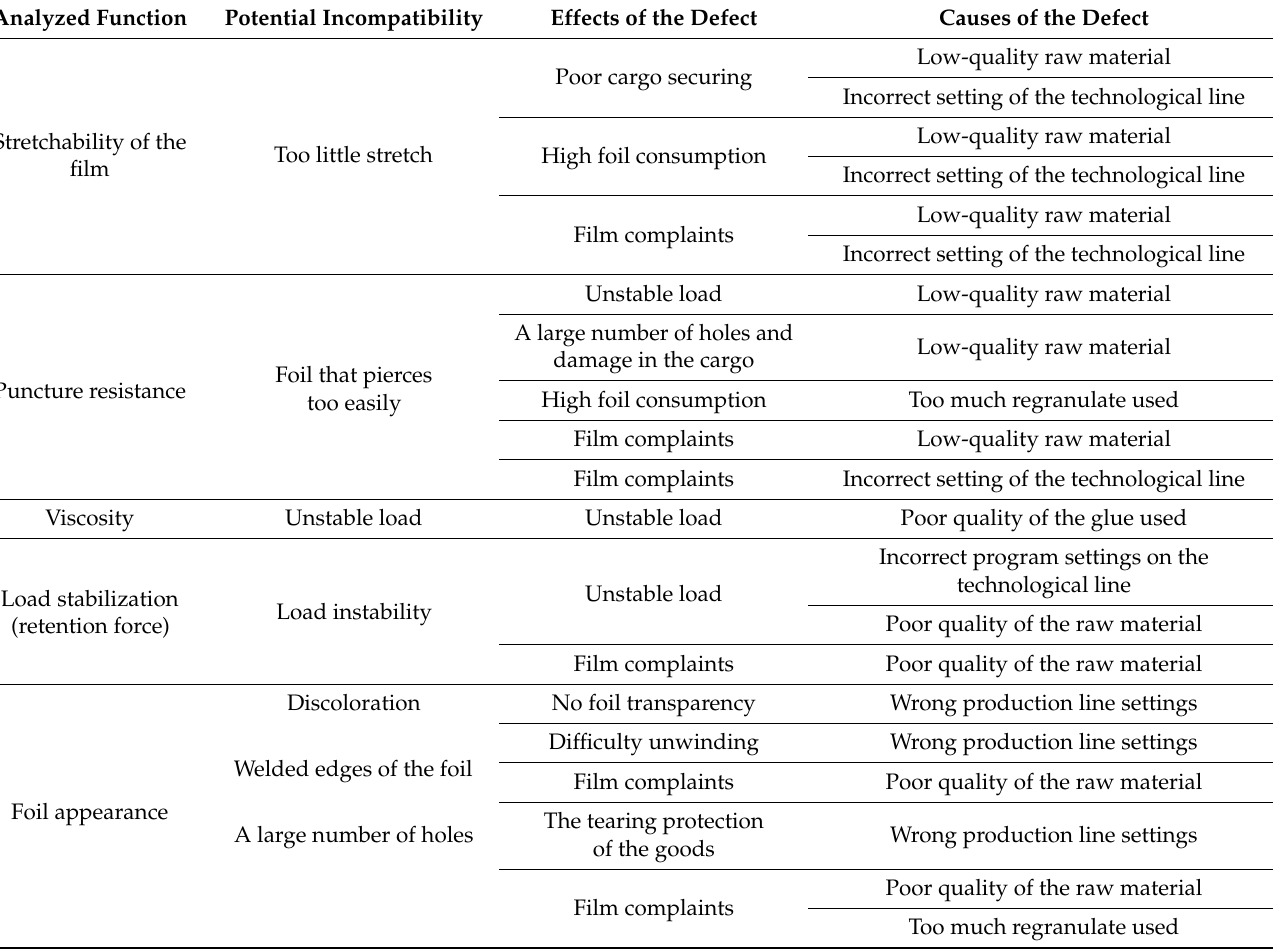
Table 10. Defects of process production of five-layer stretch film for manual